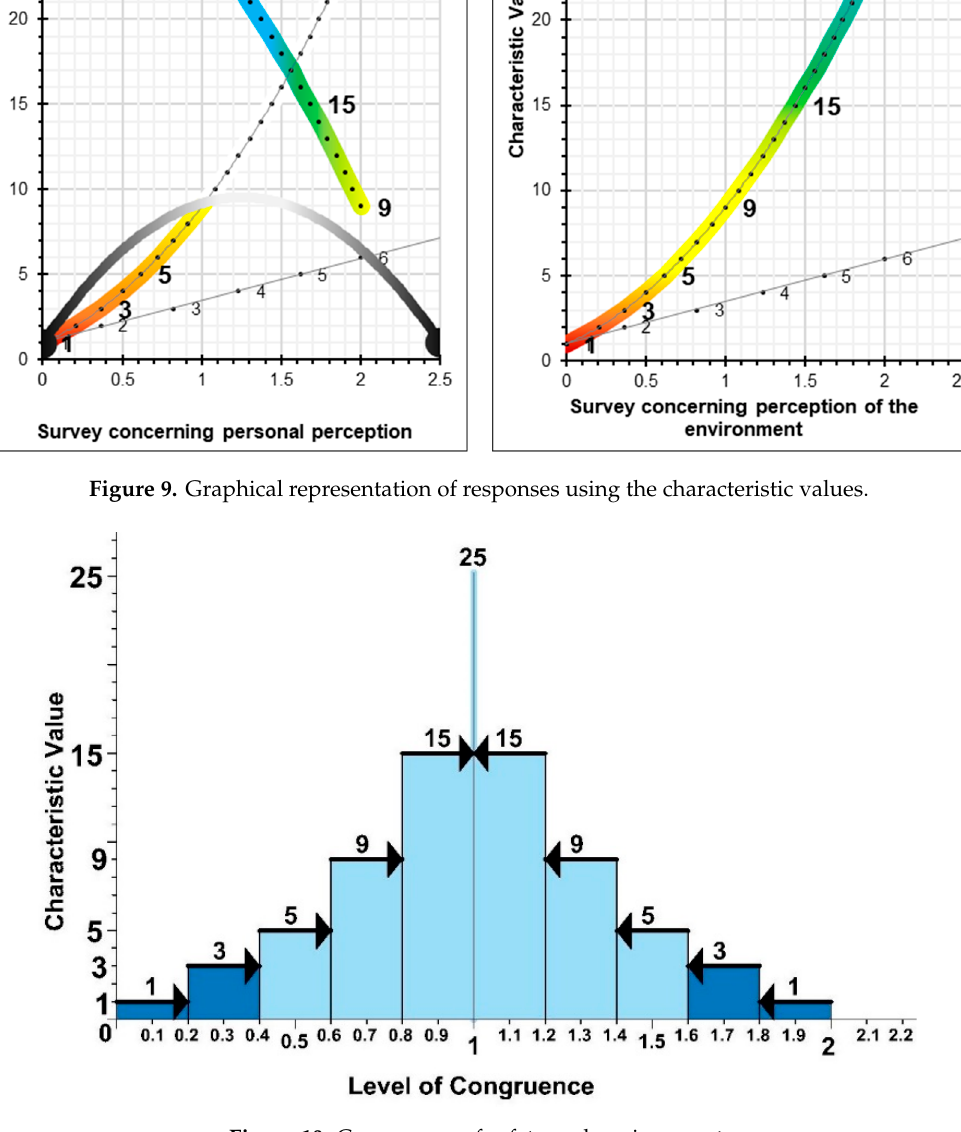
Figure 10. Congruence of safety and environment.